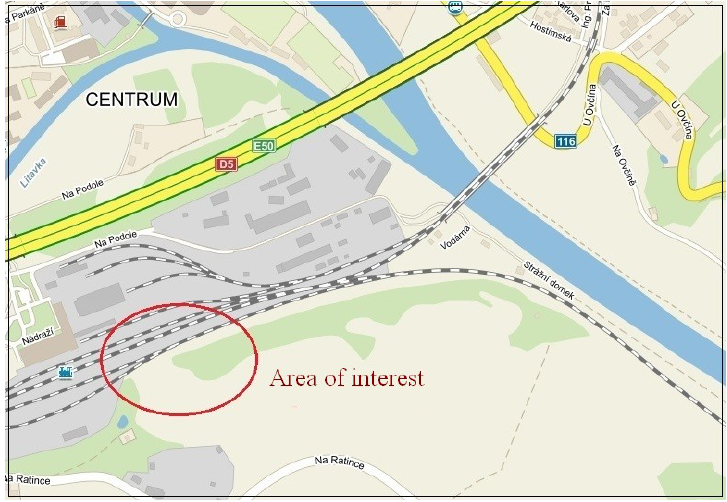
Figure 1. Layout of the location of concern.